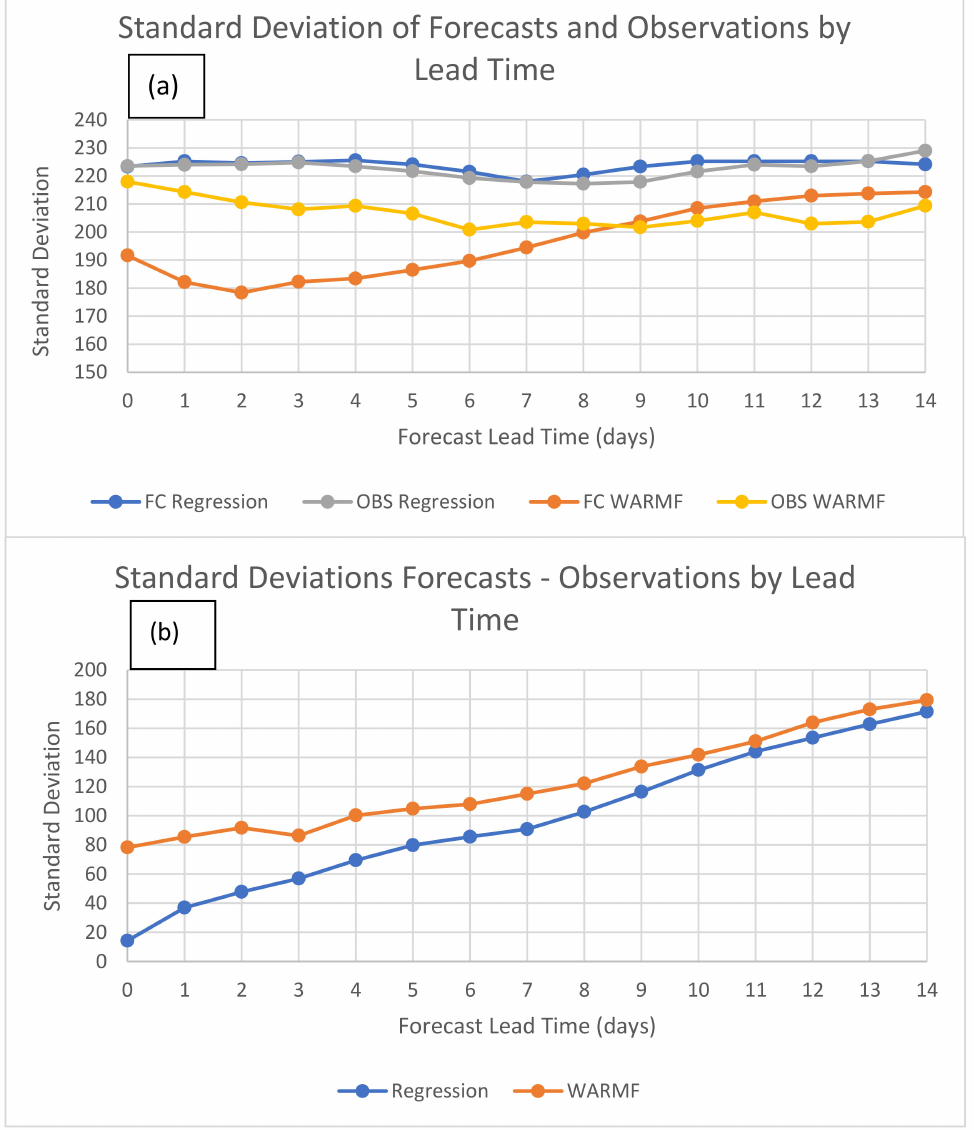
Figure 7. ( a , b ). Comparison of the standard deviations of forecasted EC and observed EC and standard deviations of differences between EC forecasts and EC observations for the Regression and WARMF models by lead time in the period between 22 February 2018 and 22 May